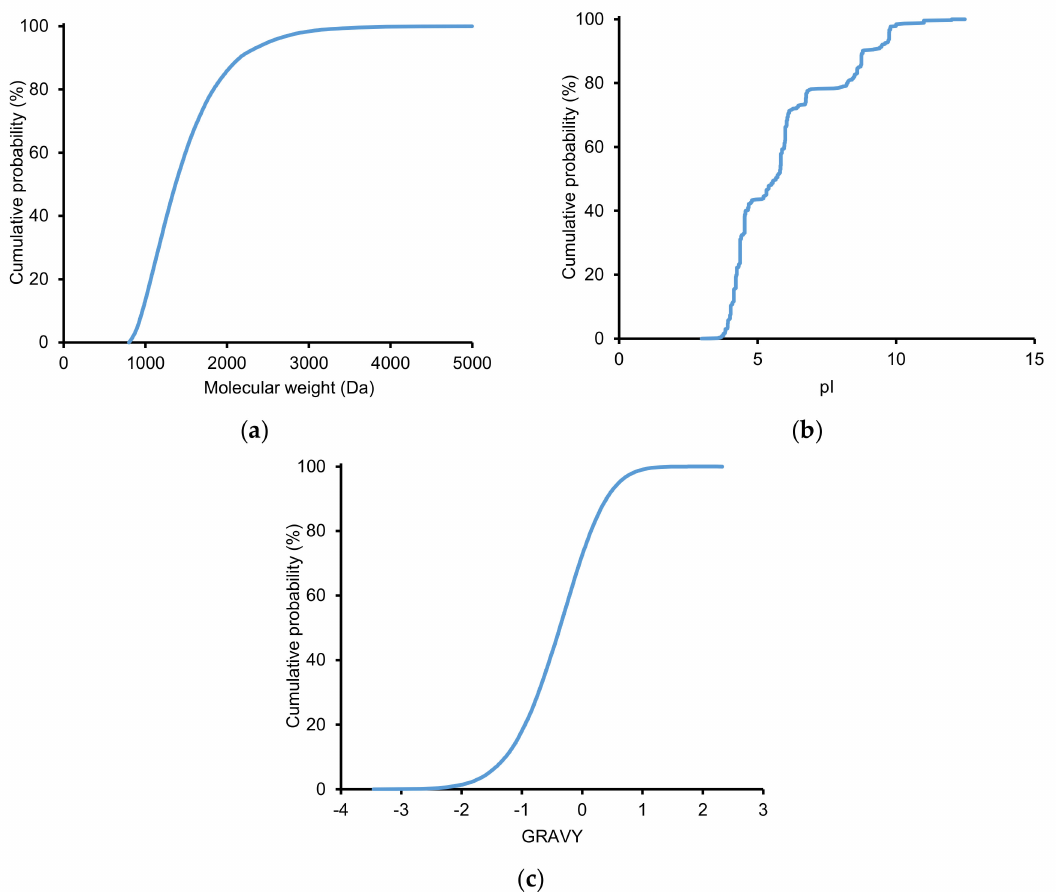
Figure 3. Cumulative distribution of ( a ) molecular weight, ( b ) isoelectric point (pI), and ( c ) the grand average of hydropathy (GRAVY) value of identified peptides. GRAVY values of peptides were calculated using the GRAVY calculator (http: // gravy-calculator.de / ); negative GRAVY values signify hydrophilicity, and positive values indicate